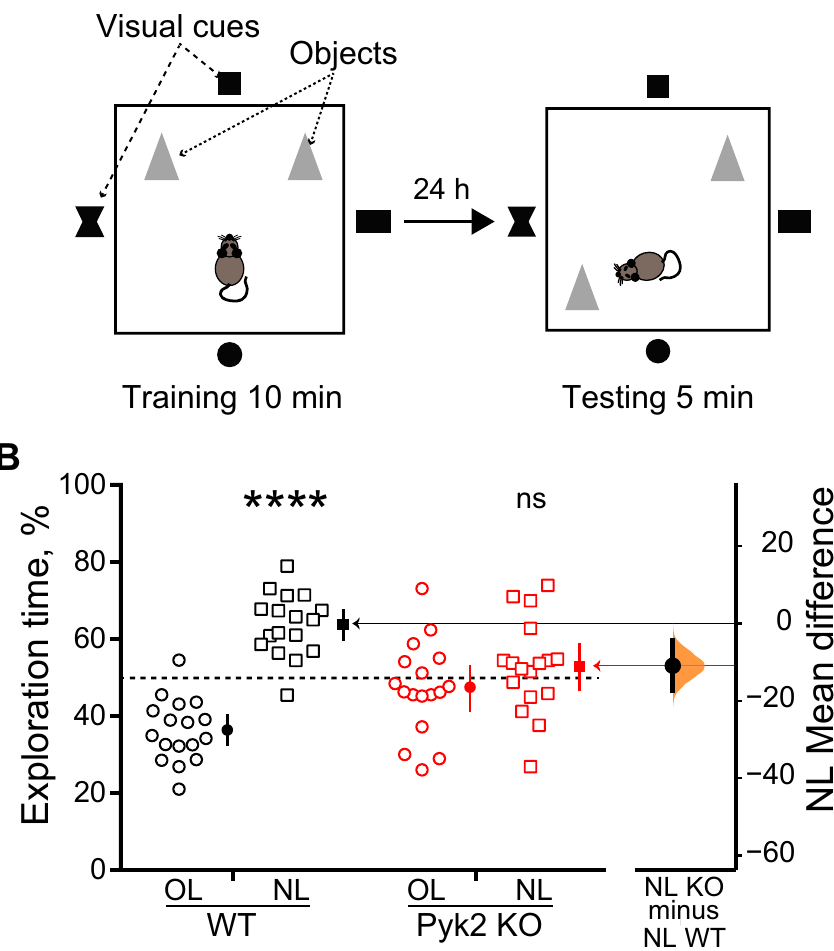
Figure 1. Pyk2 knockout alters novel object location (NOL). ( A ) Schematic representation of the test principle. After habituation of the mouse to the arena, two identical objects (indicated as grey triangles) are positioned and the animal is allowed to explore them for 10 min (left panel). Black on white visual cues outside of the arena facilitate spatial location of the objects. One day later the mouse is placed for 5 min in the same arena in which the location of one of the two objects has been modified. The time spent exploring the displaced object (new location, NL) and the unmoved object (old location, OL) is measured by video tracking. ( B ) Time spent exploring OL and NL is plotted on the left axis with open symbols for individual mouse values of Pyk2 wild type mice (n = 17) and Pyk2 KO mice (n = 17). Closed symbols indicate means, ends of vertical bars indicate the 95% confidence interval (CI), and the horizontal dotted line indicates the chance level (50%). One-sample t-test (NL exploration time vs. 50% chance preference) WT, t 16 = 6.99, p < 10 –4 , KO, t 16 = 0.96, p = 0.35. The mean difference between NL WT and NL KO is shown as Gardner-Altman estimation plot and is plotted on a floating axis on the right as a bootstrap sampling distribution. The mean difference is depicted as a dot; the 95% CI is indicated by the ends of the vertical error bar. Comparison of NL WT vs NL KO, unpaired two-tailed t test with Welch’s correction,